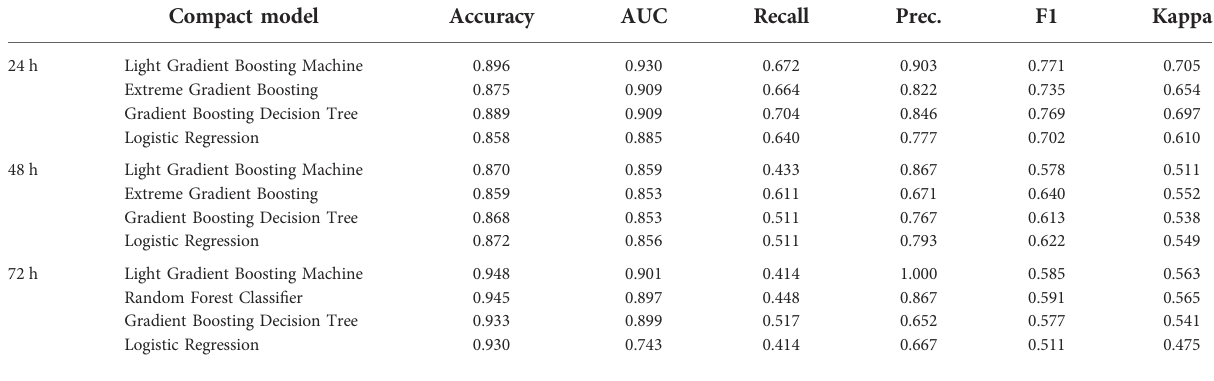
TABLE 3 Performance of compact models in the validation set. Compact model